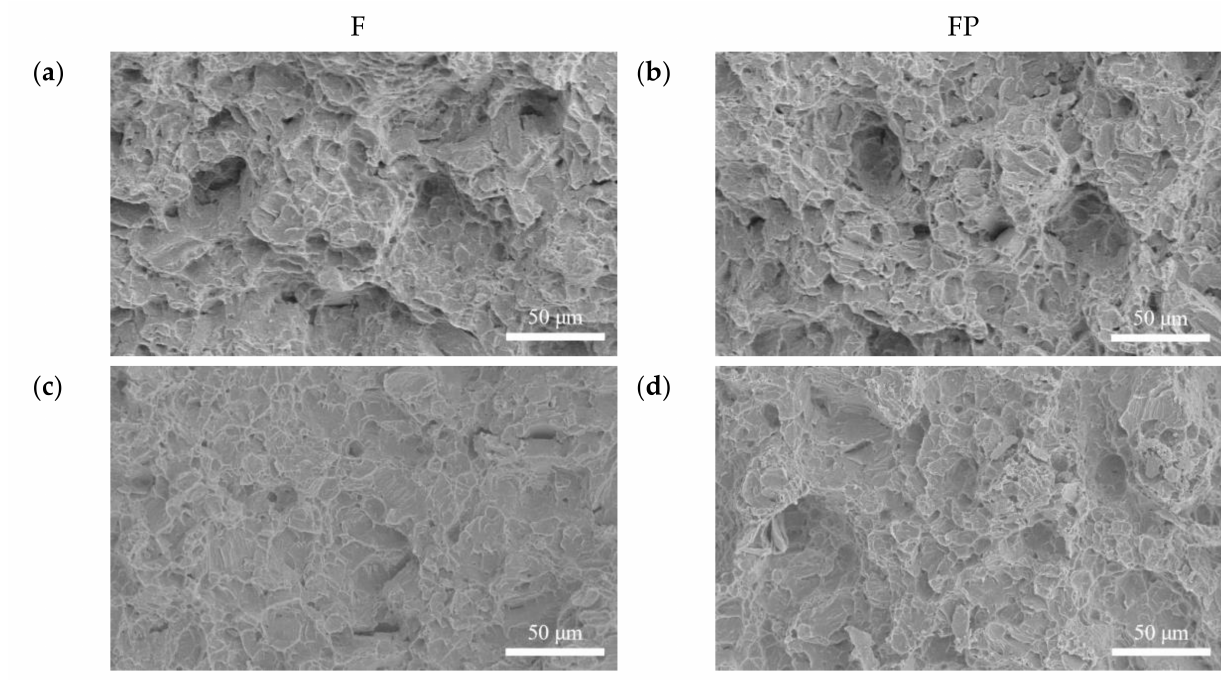
Figure 18. Impact fracture surface morphologies of ( a ) F, ( b ) FP, ( c ) F-d28, and ( d )